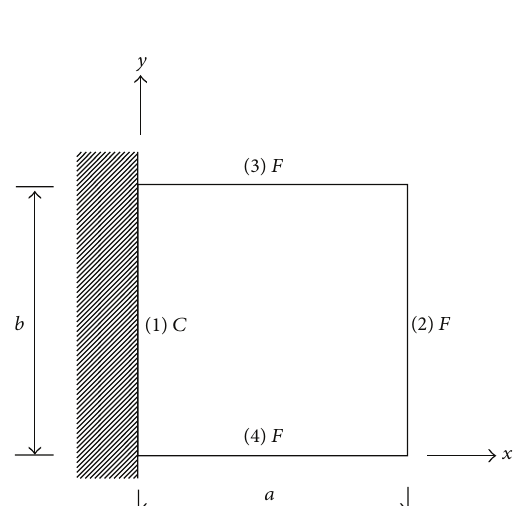
Figure 4: Geometry of FGM plates.